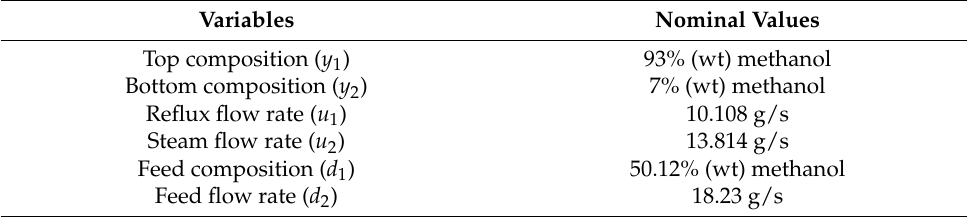
Figure 2. A binary distillation column with tray temperature control scheme. Table 1. Nominal distillation column operation data.